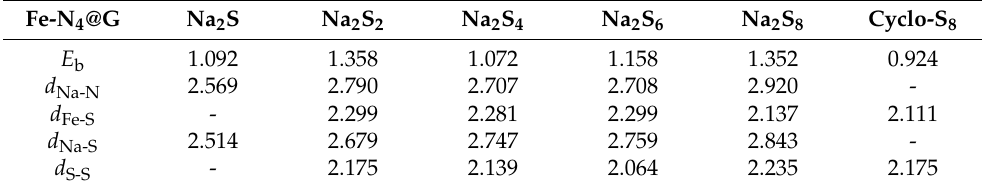
Figure 4. The optimized structures of cyclo-S 8 and Na 2 S n (n = 1, 2, 4, 6, and 8) adsorbed on the surface of Fe-N 4 @graphene. The black, blue, yellow, orange, and brown balls represent carbon, sodium, sulfur, nitrogen, and iron atoms, respectively. Table 2. The adsorption energies E ad (eV) and the average bond length d (Å) of Na 2 S n species and cyclo-S 8 after absorbing on Fe-N 4 @graphene.